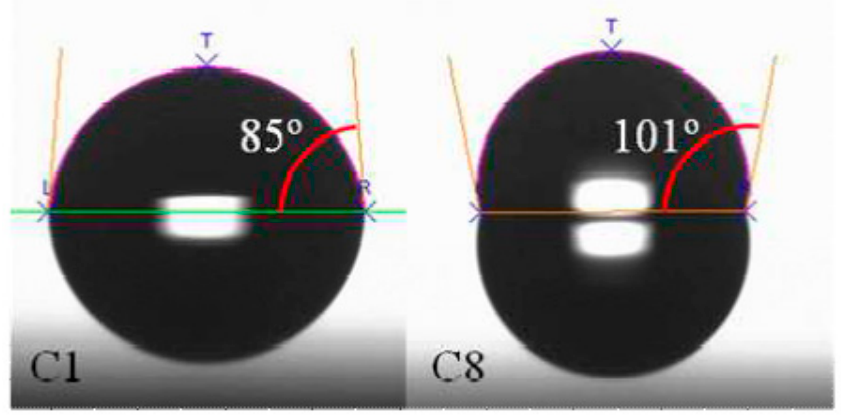
Figure 38. Contact angle test of C1 and C8 [243].